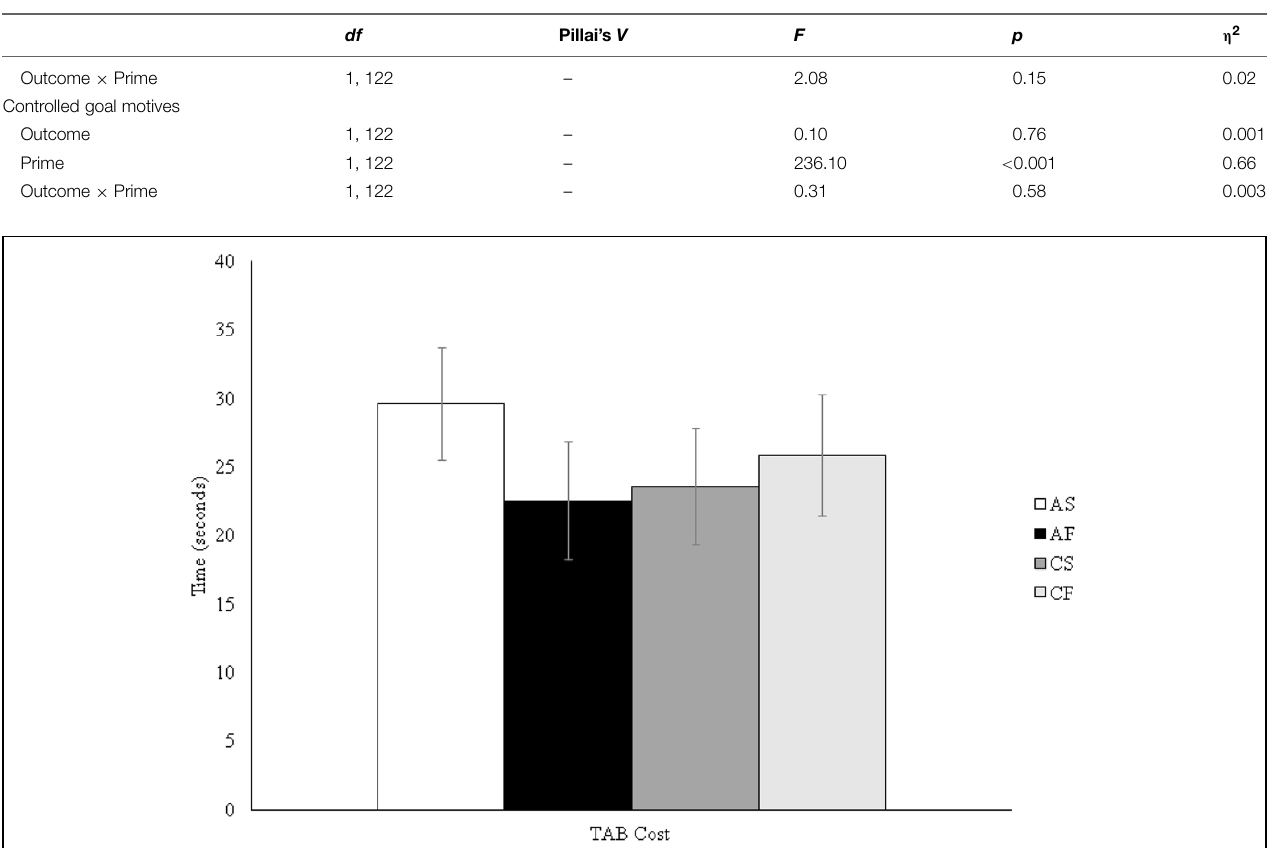
FIGURE 1 | Trial making test (TMT) TAB cost by experimental condition. AS, autonomous success; AF, autonomous failure; CS, controlled success; CF, controlled failure.